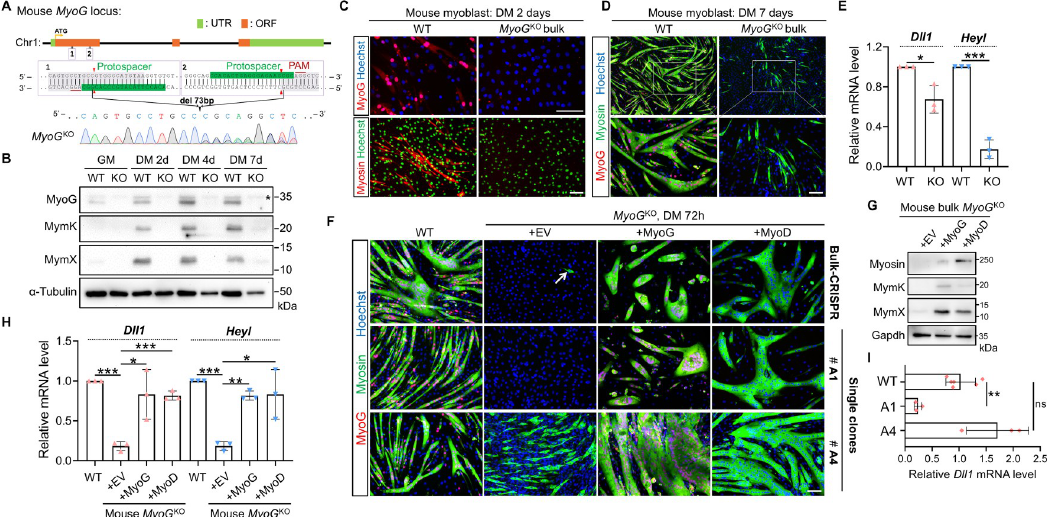
Fig 7. Responses of Dll1 expression upon deletion of MyoG from mouse myoblasts. ( A ) Schematic of mouse MyoG gene structure and an example of Sanger sequencing result after CRISPR/Cas9 mediated gene editing in C2C12 mouse myoblasts. ( B ) Western blotting results to show the expression levels of myogenic markers in WT and MyoG KO myoblasts. Star highlights a non- specific band. ( C , D ) Immunostaining results of mouse WT and MyoG KO myoblasts at day 2 (C) and day 7 (D) post differentiation. ( E ) qPCR results of Dll1 and Heyl in WT and MyoG KO myoblasts. Cells were differentiated for 48 hours. n = 3. ( F ) Immunostaining result of MyoG and myosin for bulk CRISPR-treated myoblasts (top) and two isolated KO clones (bottom). Note that although MyoG were invariably depleted, the two KO clones showed a large variation of myogenic capacity. Cells were induced for differentiated for 72 hours. ( G ) Western blotting results to show the expression levels of myogenic differentiation markers in and bulk CRISPR-treated MyoG KO myoblasts. Cells were differentiated for 72 hours. ( H , I ) qPCR results for gene expression in WT and bulk CRISPR-treated MyoG KO myoblasts (H) or MyoG KO single-knockout clones (I). Cells were differentiated for 48 hours. n = 3. Data are means ± SEM. � P < 0.05, �� P < 0.01, ��� P < 0.001. ns, not significant. Scale bars, 100 μ m.